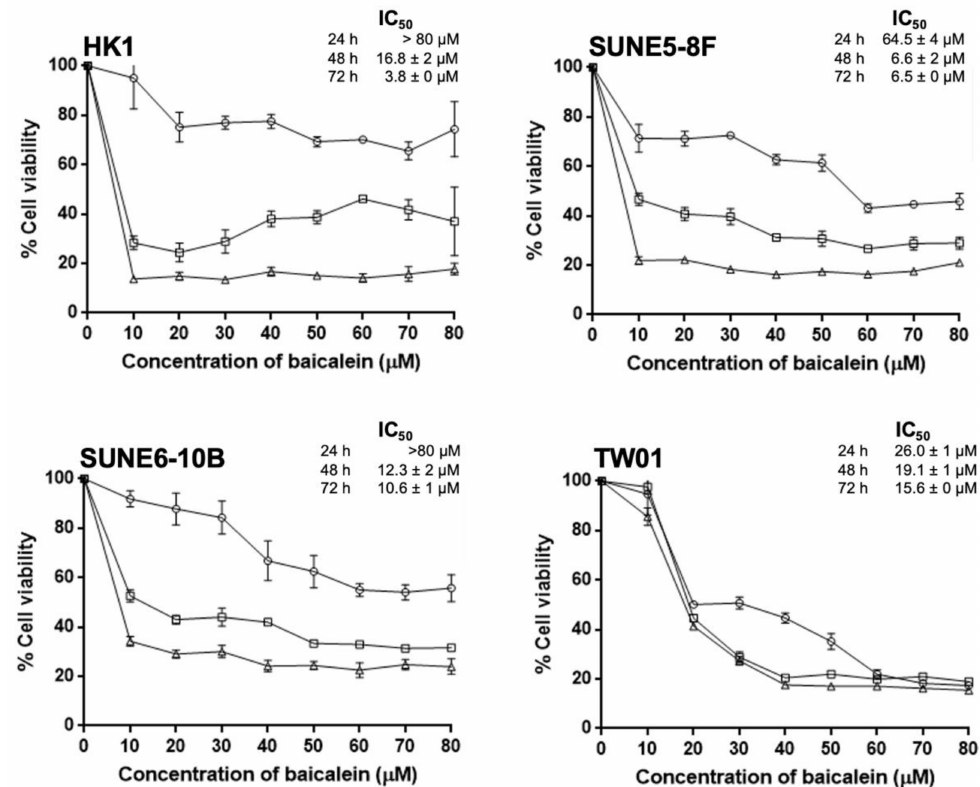
Figure 1. aGrowth inhibition profiles of four NPC cell lines, namely HK-1, SUNE 5-8F, SUNE 6-10B, and TW01, were determined by the MTT assay. All cells were treated with various concentrations of baicalein from 0 to 80 µ M for 24, 48, and 72 h. The percentage of NPC cell viability was compared between baicalein-treated cells and the control. The IC 50 values of baicalein inhibiting four NPC cell lines at 24, 48, and 72 h are shown. The IC 50 values were obtained using the GraphPad Prism 6 program (San Diego, CA, USA). Data represent the mean ± standard error of the mean from three independent